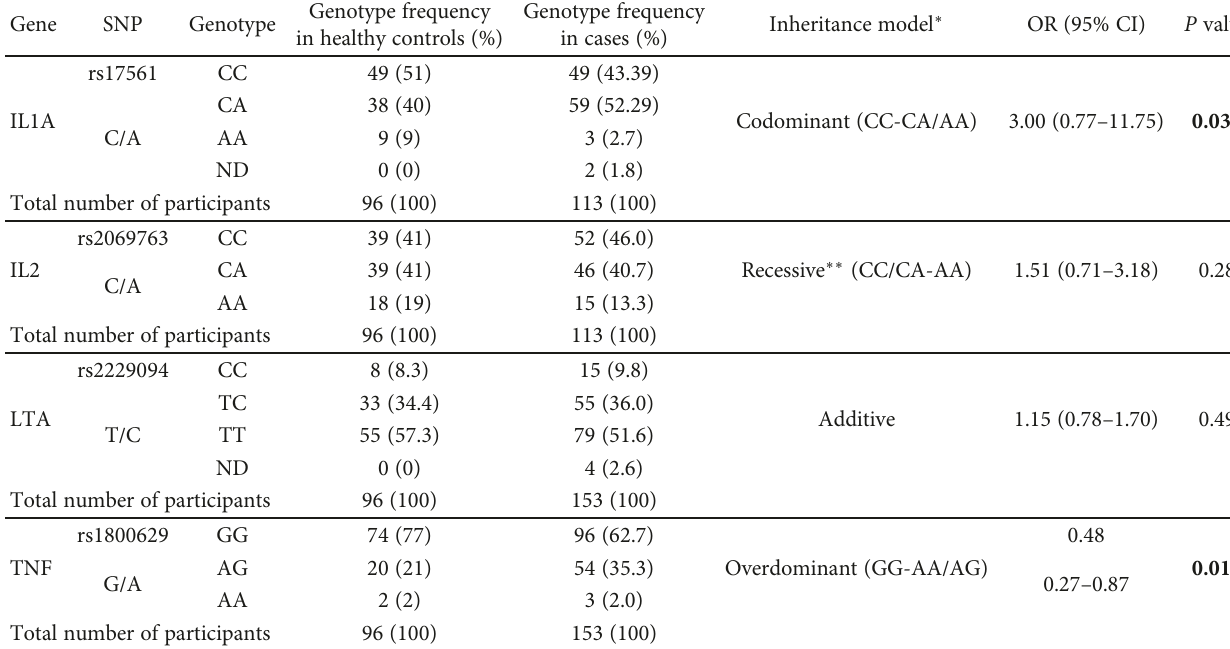
Table 2: Genotype distributions of 4 SNPs in Slovenian patients with PVR and 96 healthy controls. Inheritance models and odds ratios (ORs) were determined.